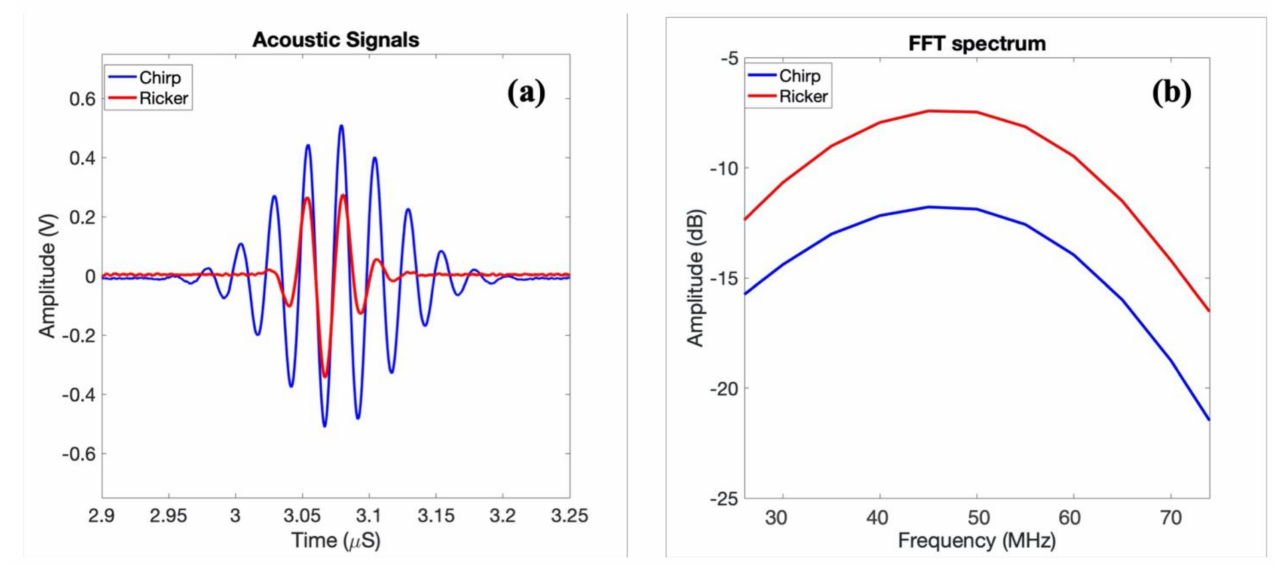
Figure 5. ( a ) Ultrasonic measurements of the focused transducers reflections from the glass plate at a focal point of the in-house transducer; ( b ) frequency spectra in dB scale corresponding to ( a